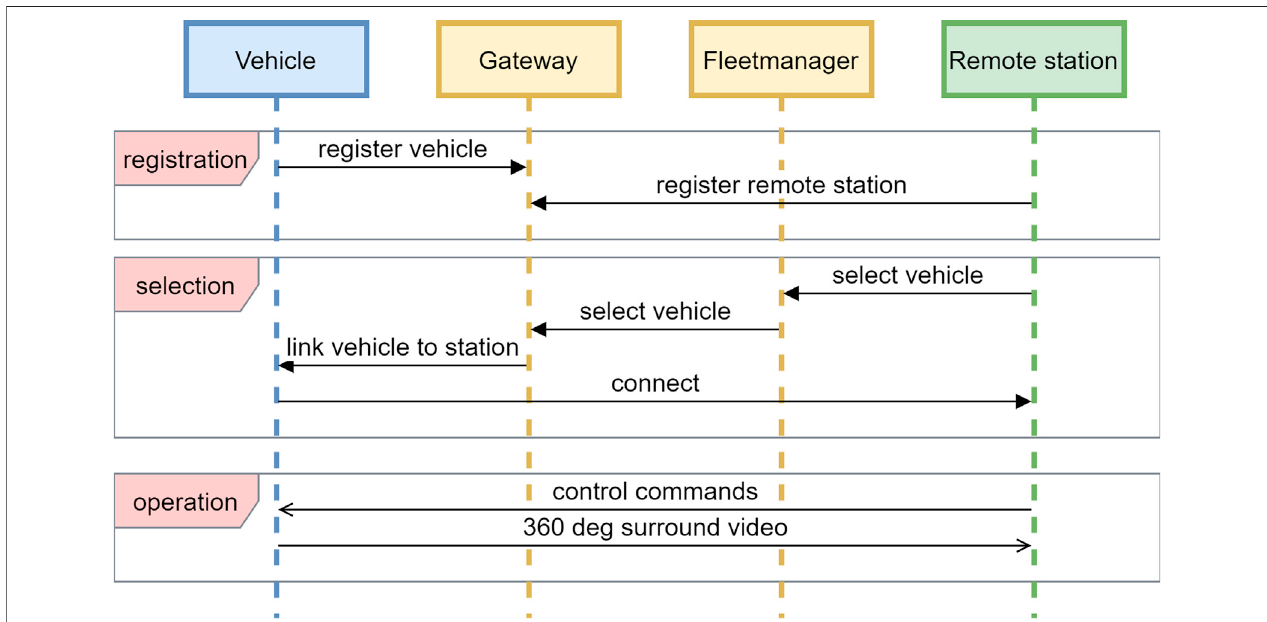
FIGURE 3 | Simpli fi ed sequence diagram of the communication between vehicles, gateway, fl eet manager, and remote stations. Multiple vehicles and remote stationscanbedeployedsimultaneously,wherethe fl eetmanagerisresponsibleforthemanagementofthesystemandthegatewayforactuallyaspeci fi cremotestation to a speci fi c